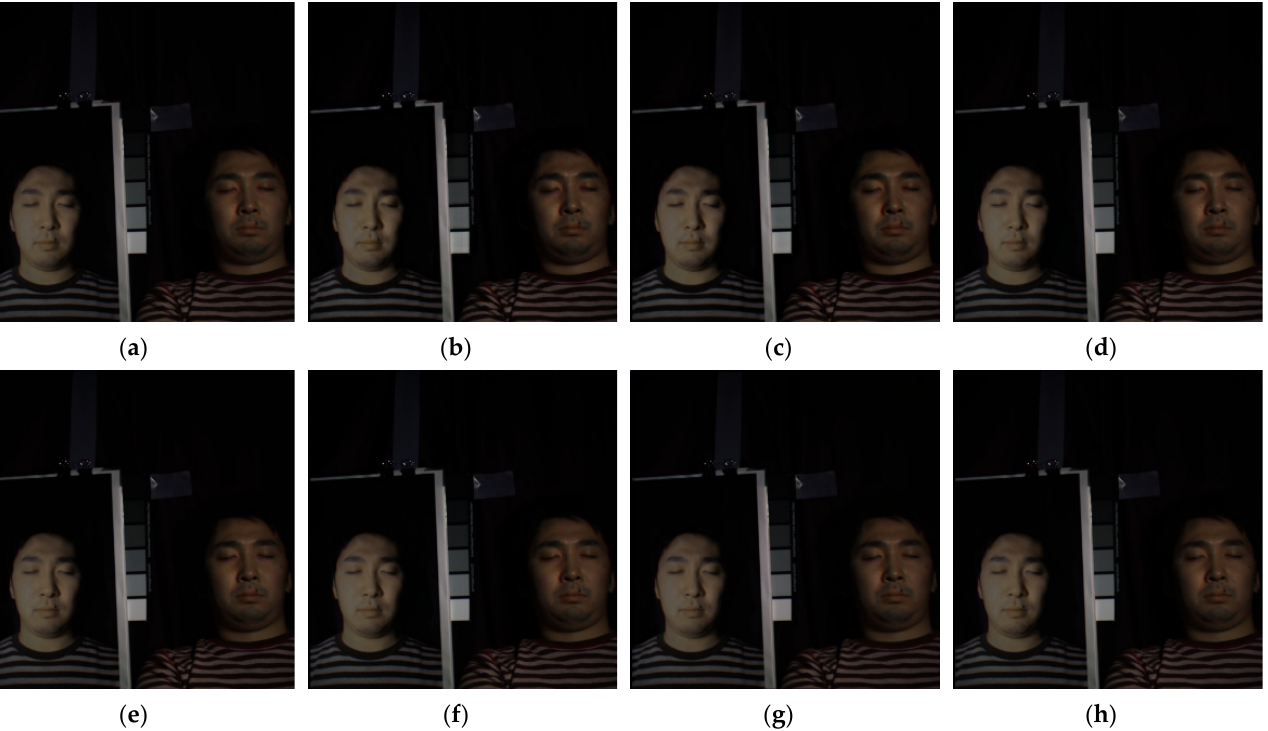
Figure 2. Results of CAVE dataset with simulated multispectral images. ( a ) results of GSA; ( b ) results of SFIMHS; ( c ) results of GLPHS; ( d ) results of CNMF; ( e ) results of ICCV15; ( f ) results of HySure; ( g ) ours results; ( h ) Ground truth. Table 1. Quantitative evaluation results of CAVE dataset with simulated multispectral